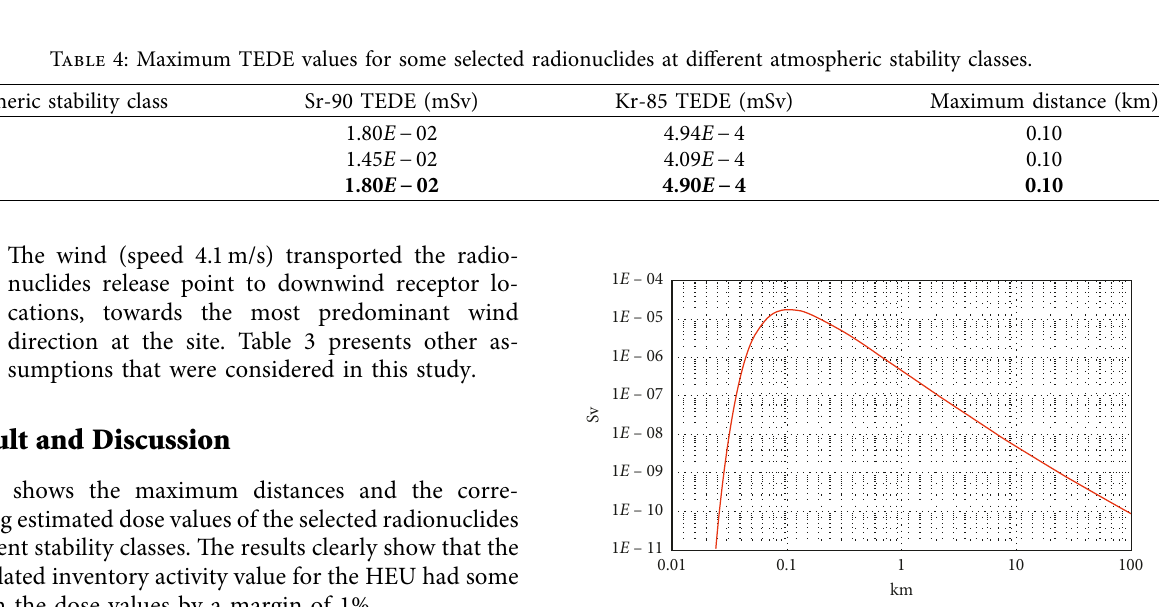
Figure 3: Total effective dose equivalent (TEDE) as a function of receptor downwind distance of Sr-9 for stability class